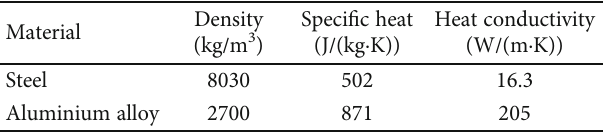
Table 2: Properties of solid